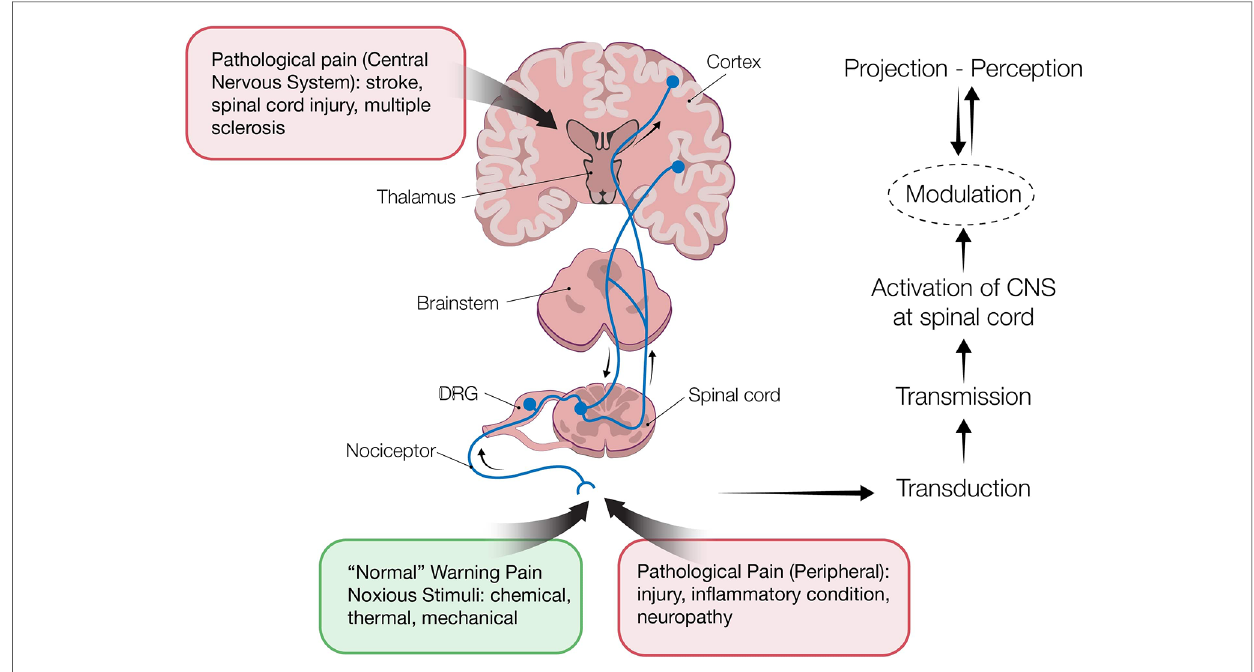
FIGURE 1 Pain pathways: transduction-transmission-perception-modulation. Transduction refers to activation of peripheral nociceptors (primary afferent neurons) from various stimuli. Cell bodies of nociceptors neurons are located in the dorsal root ganglia (DRG) (innervating the skin, deep tissues, visceral organs) and trigeminal ganglia (innervating the face). Nociceptors express transducers on their distal terminus, which are high-threshold ion channels, such as transient receptor potential ion channels [TRPs, ATP- gated ion channels, and acid-sensing ion channels (ASIC)]. These are responsible for converting the stimuli to action potential (AP). Next is the transmission process during which primary afferent neurons transmit the AP to the spinal cord, via their axons that terminate in the spinal dorsal horn (DH). Perception refers to the projection of pain signals in the brain, during which complex neuronal networks in the brain receive and “ translate ” from the spinal cord information about duration, location, and intensity of pain. Modulation is the process by which the nervous system either enhances or inhibits pain signals. Alteration of pain impulses occurs due to three endogenous mechanisms. 1. Segmental inhibition during which the inhibitory nerve in the spinal cord can be blocked to transmit noxious stimuli from C- fi bers as a result of stimulation of the non-noxious A β fi bers nociceptors (the “ gate theory ” ). The method of pain management with transcutaneous electrical nerve stimulation is based on this theory. 2. The opioid system consists of opioid receptors in the brain, spinal cord and peripheral nerves that are activated by the binding of endogenous opioids (enkephalins, endorphins, and dynorphins). 3. The descending inhibitory nerve system, projecting via the midbrain, inhibits nociceptive transmission at the spinal cord dorsal